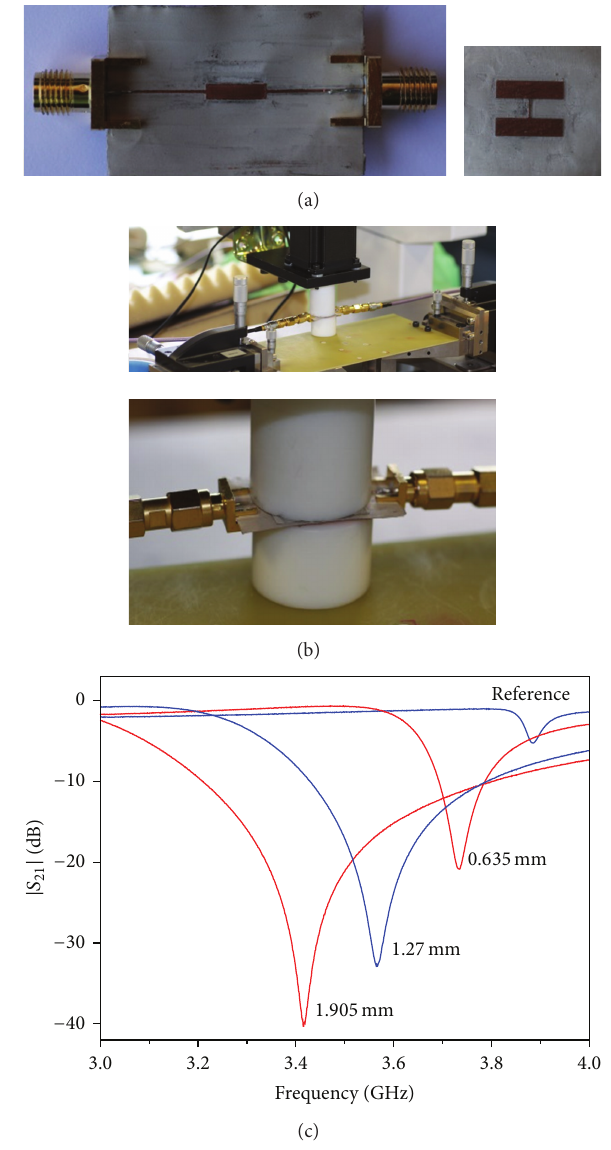
Figure 7: Photograph of the fabricated SIR loaded microstrip line of Figure 4 on separate substrates, where matched input/output lines of 𝑊 = 0.2 mm have been added to solder the connectors (a). Photograph of the experimental setup with the substrates attached to Teflon slabs (a material with a low dielectric constant, 𝜀 𝑟 = 2.08 ) and with manual positioners labeled in inches (b). Measured transmission coefficient for some lateral displacements of the SIR